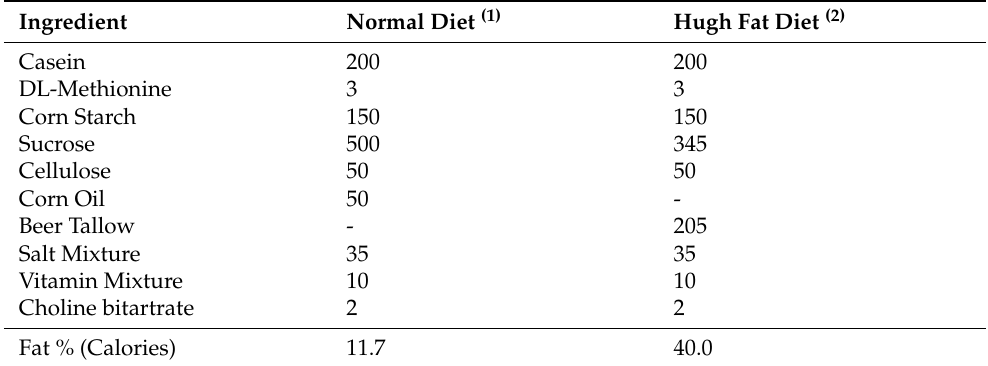
Table 1. Composition of the experimental